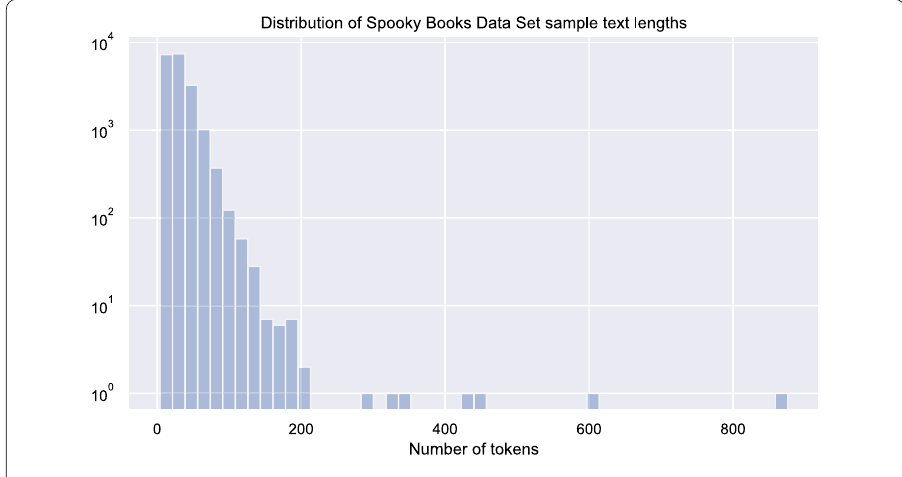
Figure 1 Distribution of the sample text lengths in the Spooky Books Data Set. Average = 30.4 tokens, median = 26 tokens, 0.75 quantile = 38 tokens, 0.95 quantile = 65